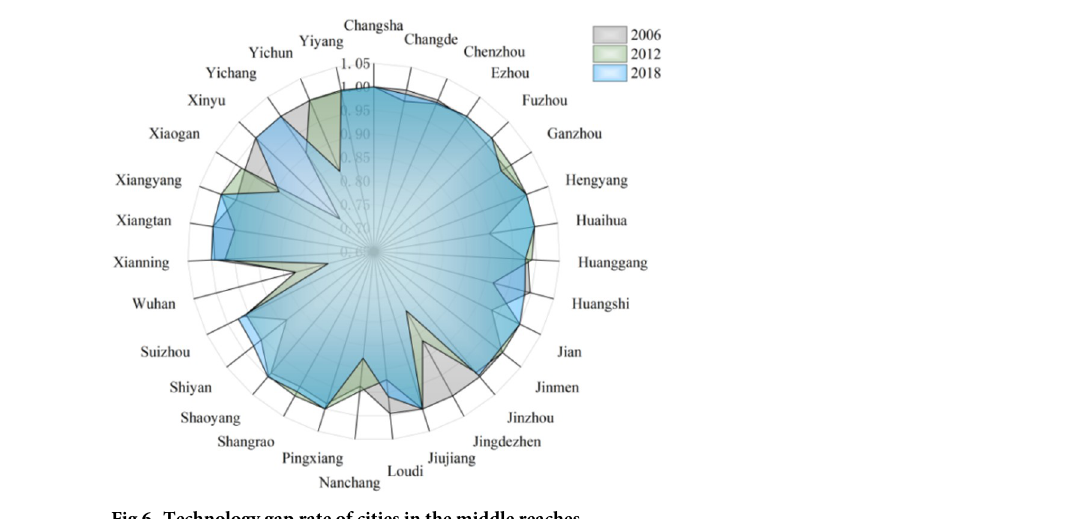
Fig 6. Technology gap rate of cities in the middle